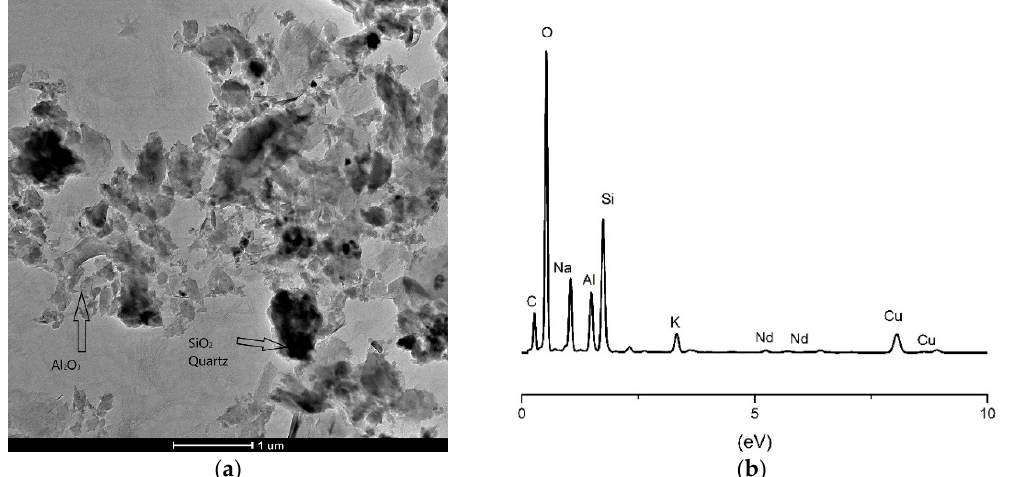
Figure 7. TEM analysis of geopolymer: ( a ) with 5% Nd; ( b ) corresponding EDS analysis .